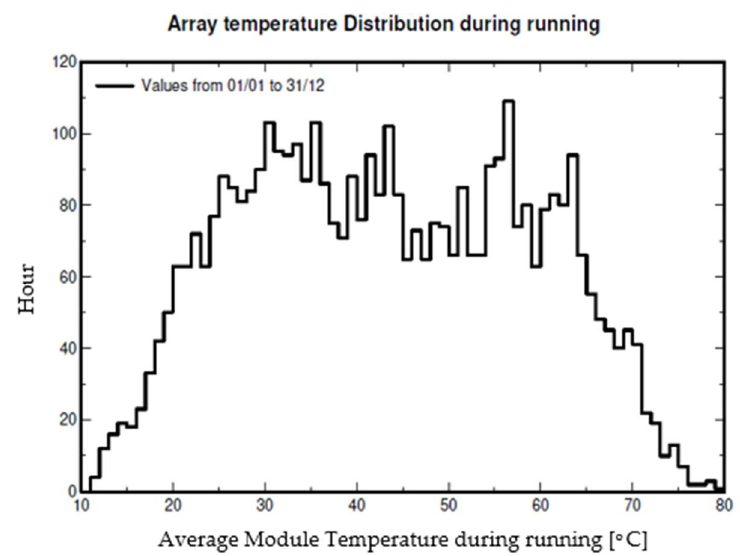
Figure 13. Showing FPV Array operational temperature.